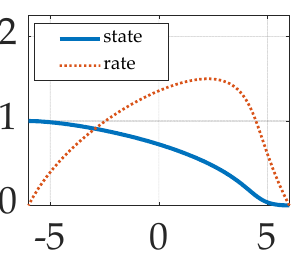
Figure 6. Input output relationship of the proposed pre-filtering technique. The abscissa is the control, while the ordinate is the state and rate trajectories, respectively.